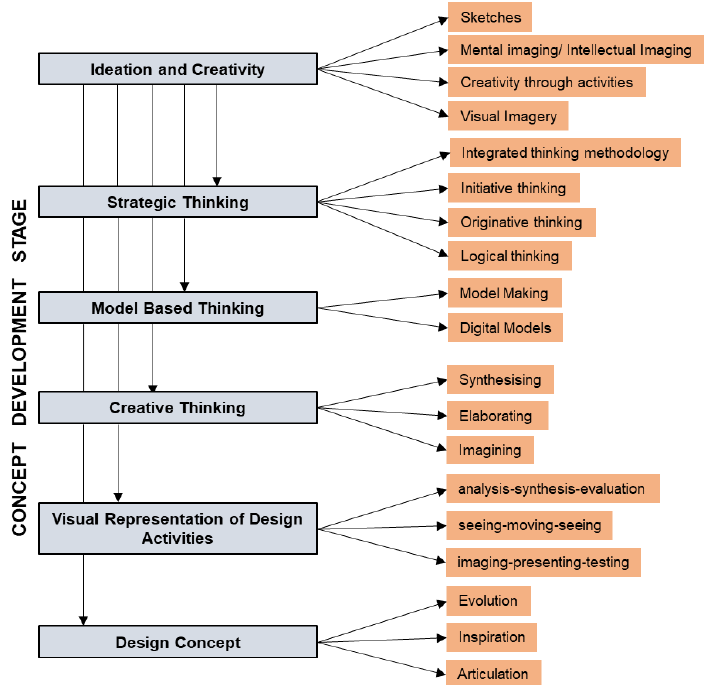
Figure 2. Stage 1: conceptual design process (source: created by